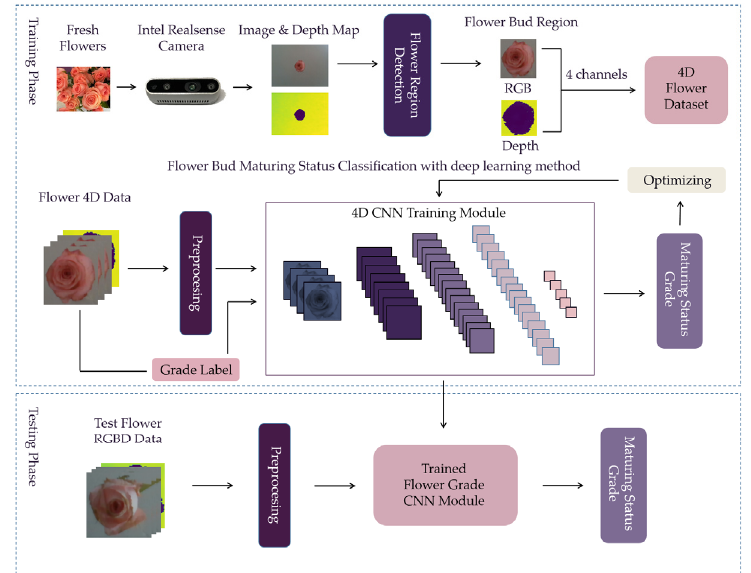
Figure 5. Diagram of the proposed method for flower classification.